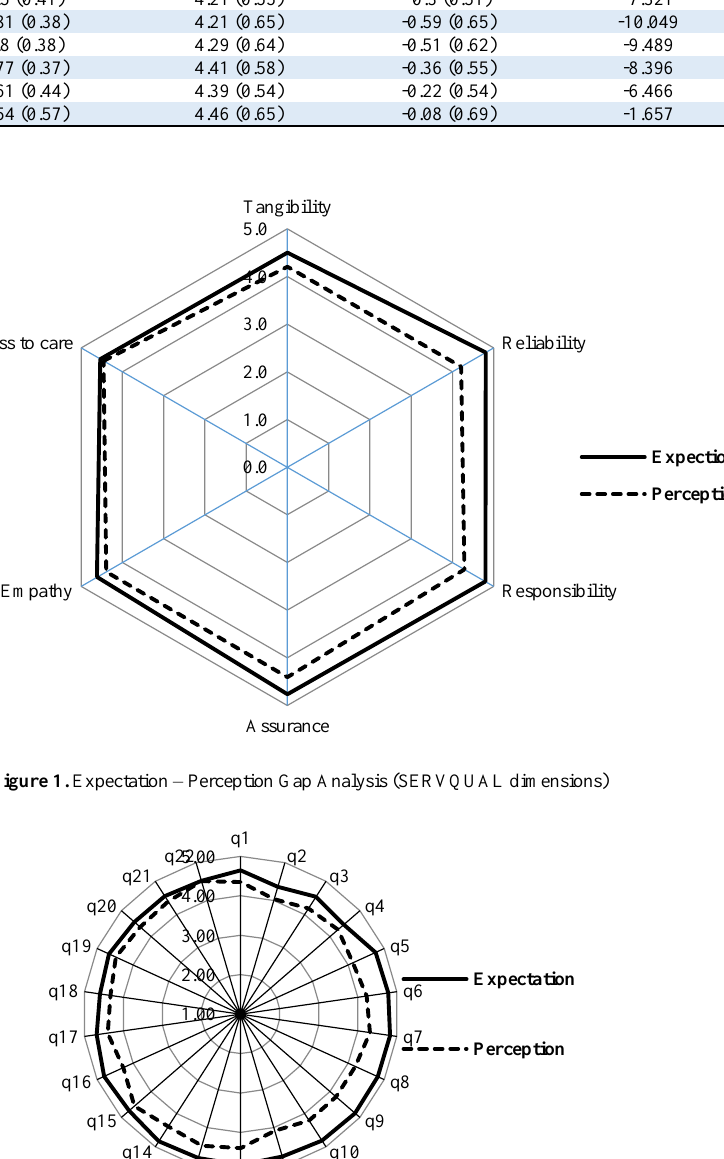
Table 2. The means, difference scores, T value, and significance obtained through the evaluation of each service quality dimension DIMENSION